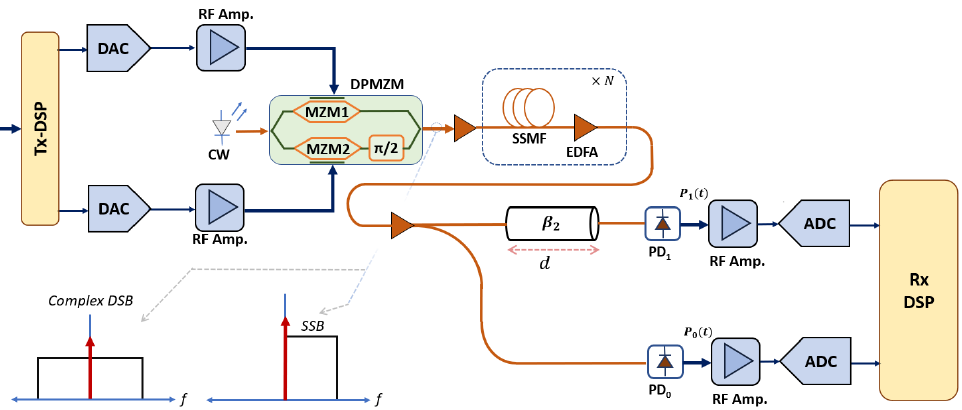
Figure 7. The simplest schematic showing carrier-assisted phase retrieval with TIE or GS